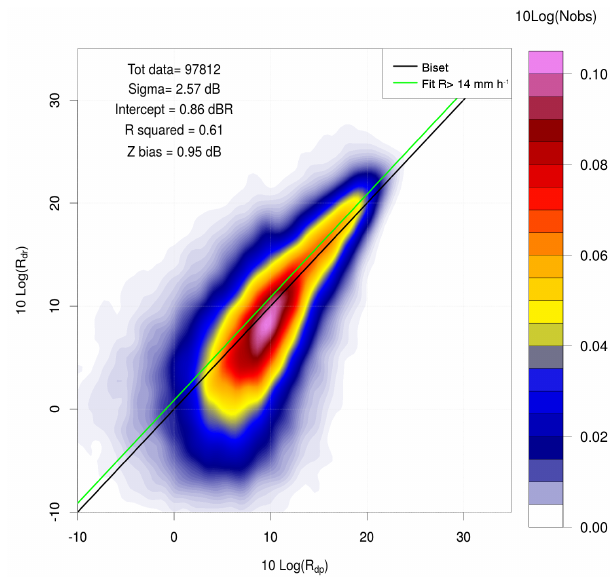
Figure 7. As in Fig. 6 but for the Monte Settepani radar.